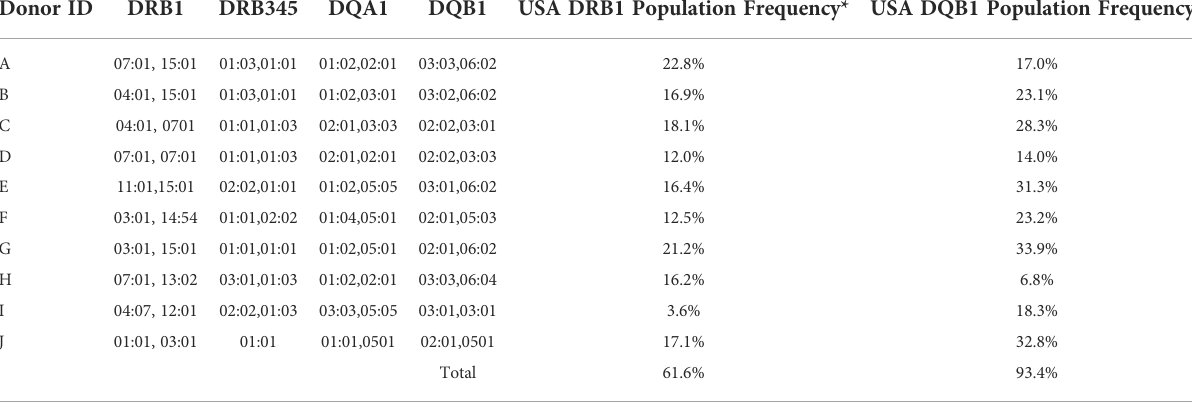
TABLE 1 Donor HLA typing and frequencies in the US